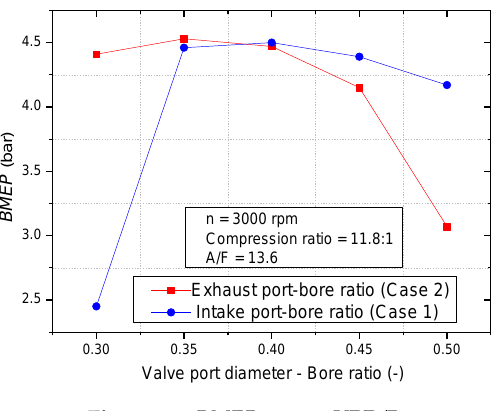
Figure 17. BMEP versus VPD/B.